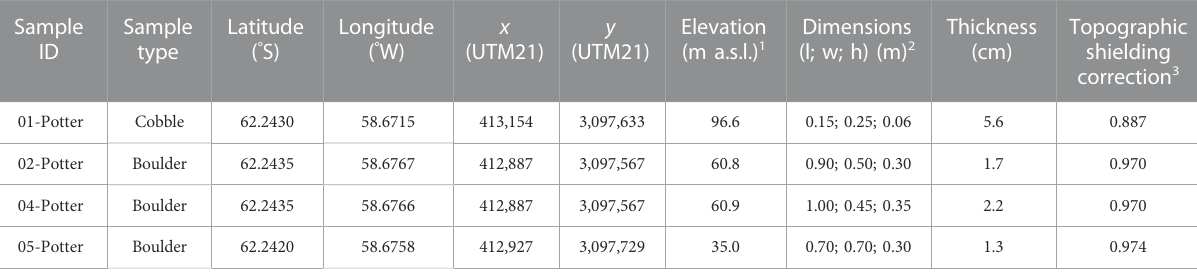
TABLE 3 Sampling information for cosmogenic 3 He nuclide surface exposure dating samples collected around Three Brothers Hill, Potter Peninsula, KGI. All surfaces were dipping less than 10 ° . Sample 01-Potter, a cobble sitting on top of a morainic crest facing Three Brothers Hill, was taken in its entirety (Supplementary Figure S1). This sample and 05-Potter have a striated, more weathered upper surface, suggesting that it was glacially transported and preserved in situ . Samples 02 – 05-Potter have boulder shapes, sizes, and positions that suggest that a recent turnover would be highly unlikely. Topographic shielding of each sample was measured with a clinometer and compass.